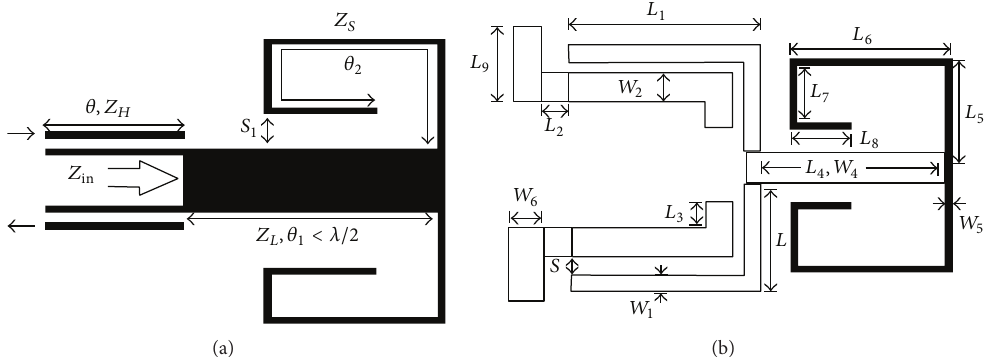
Figure 6: (a) Structure of the band-pass filter designed based on the MMR resonator shown in Figure 5. (b) The structure based on optimized values.